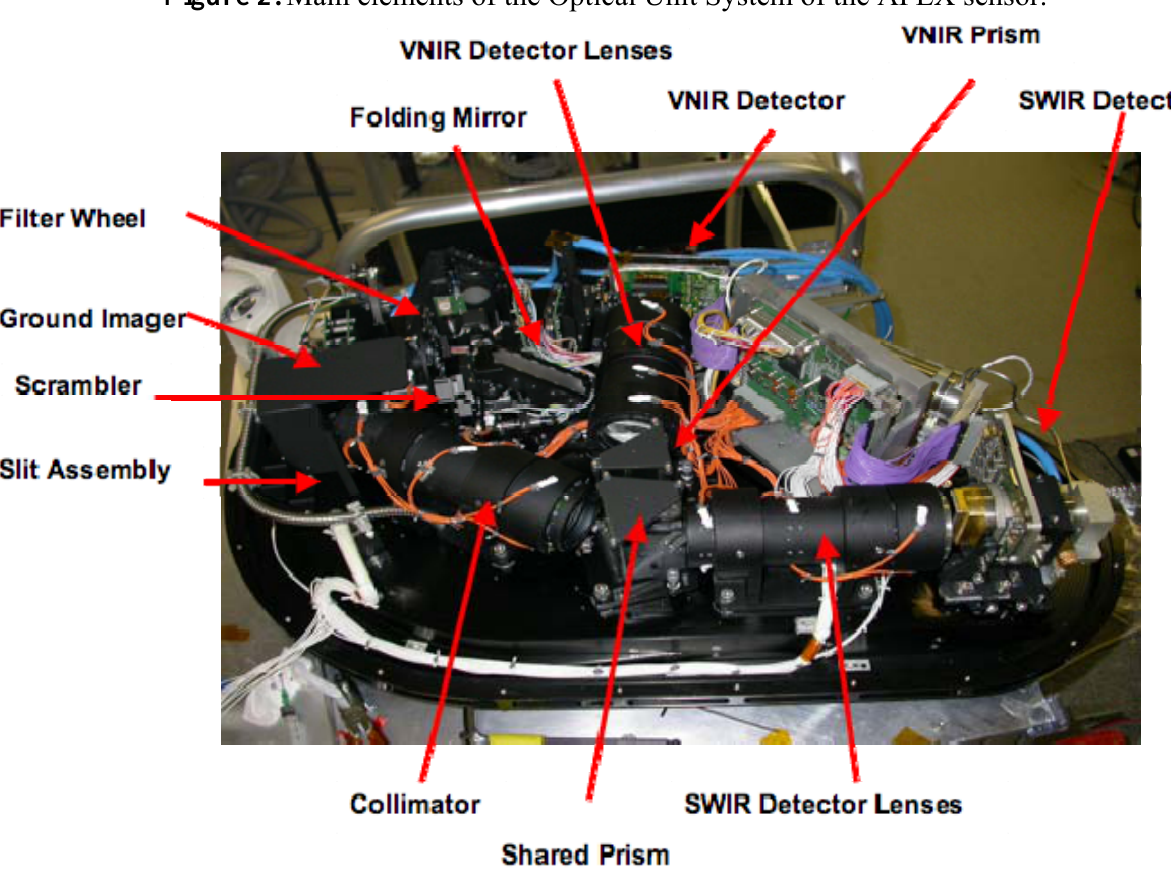
Figure 2. Main elements of the Optical Unit System of the APEX